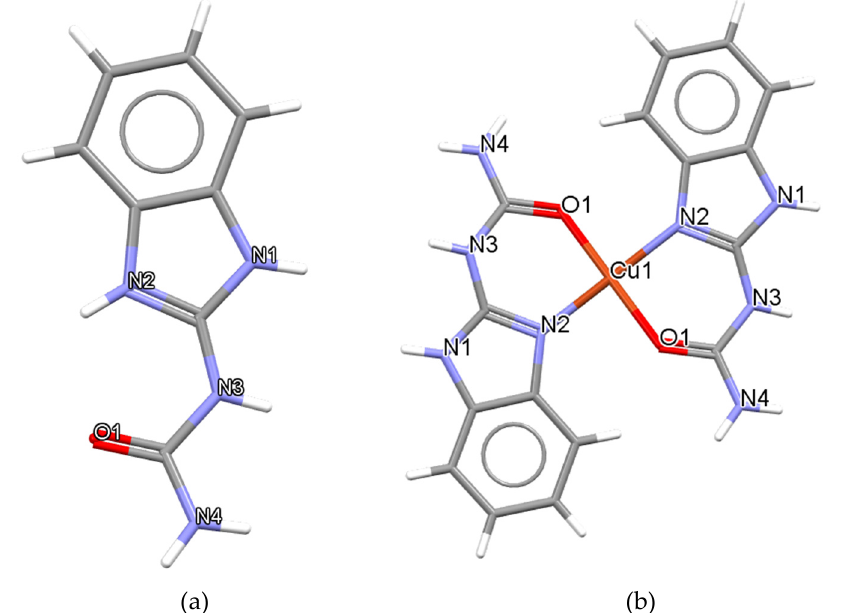
Figure 1. ( a ) BZIMU molecule, ( b ) Cu(II) complex containing two molecules of BZIMU (structures are deposited in the Cambridge Crystallographic Data Centre; CCDC 1517018 and CCDC 1517019).